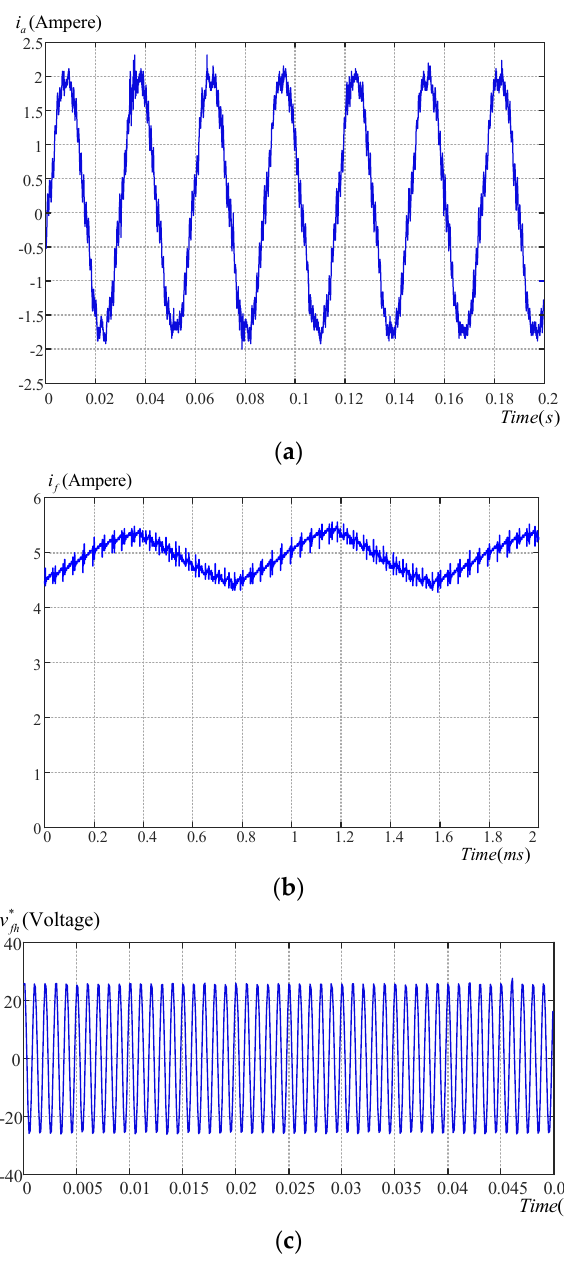
Figure 11. Measured signals at 300 r / min and 2 N.m external load; ( a ) a-phase current, ( b ) field-excited winding current, and ( c ) high-frequency voltage.